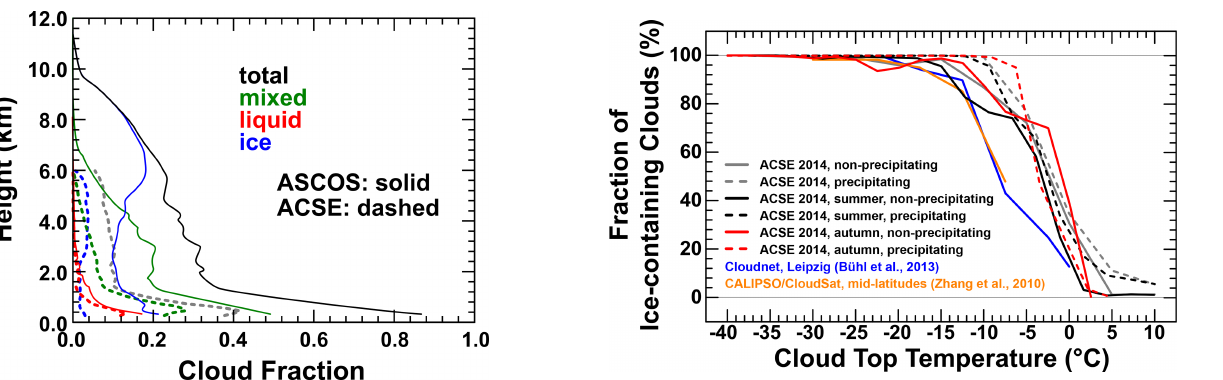
Figure 13. Profiles of cloud fraction for different cloud types as derived from measurements during ASCOS (solid, 12 August to 2 September 2008) and ACSE (dashed) for the ASCOS time pe- riod. The grey dashed line refers to all clouds, i.e. including those for which cloud top extended above the maximum measurement range of 6km height.